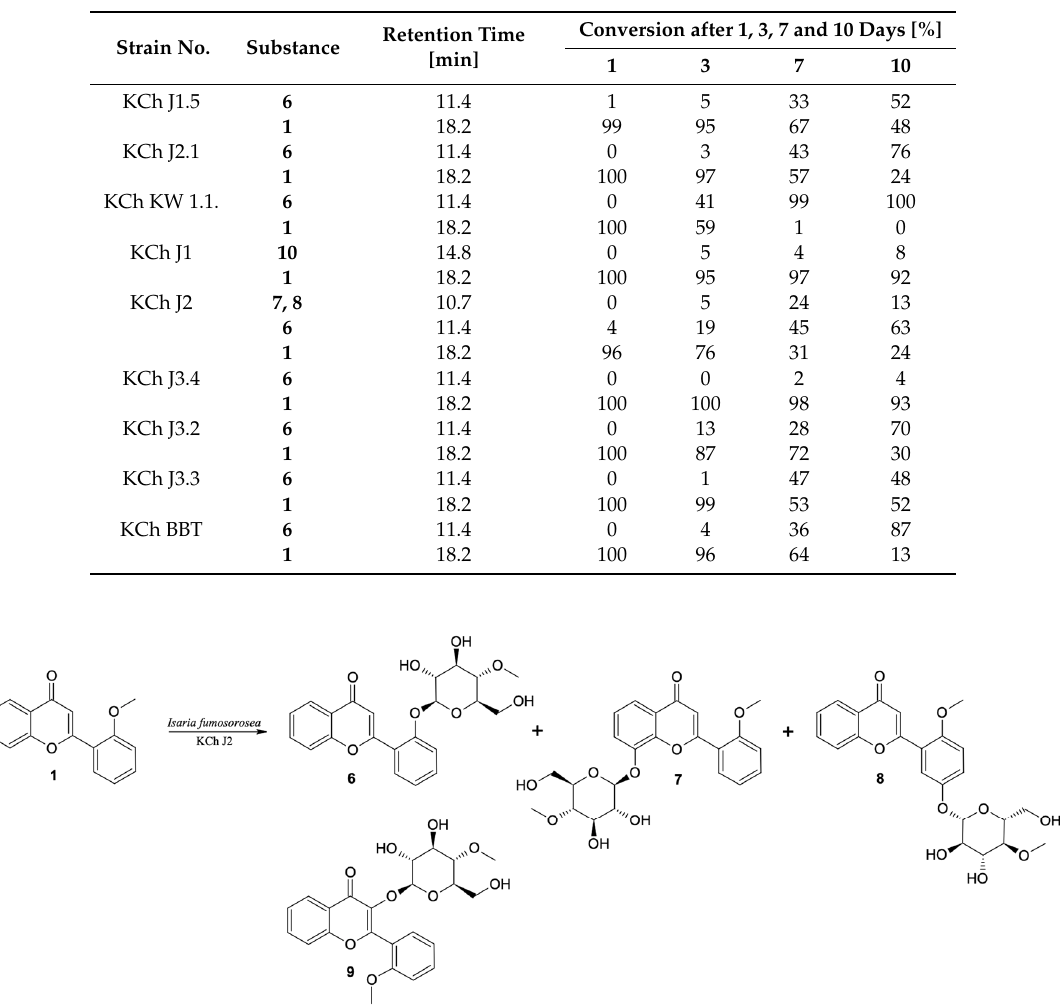
(cid:48) -methoxyflavone ( 1 ) by I. fumosorosea KCh Figure 1. Biotransformation of 2’-methoxyflavone ( 1 ) by I. fumosorosea KCh J2. Figure 1. Biotransformation of 2